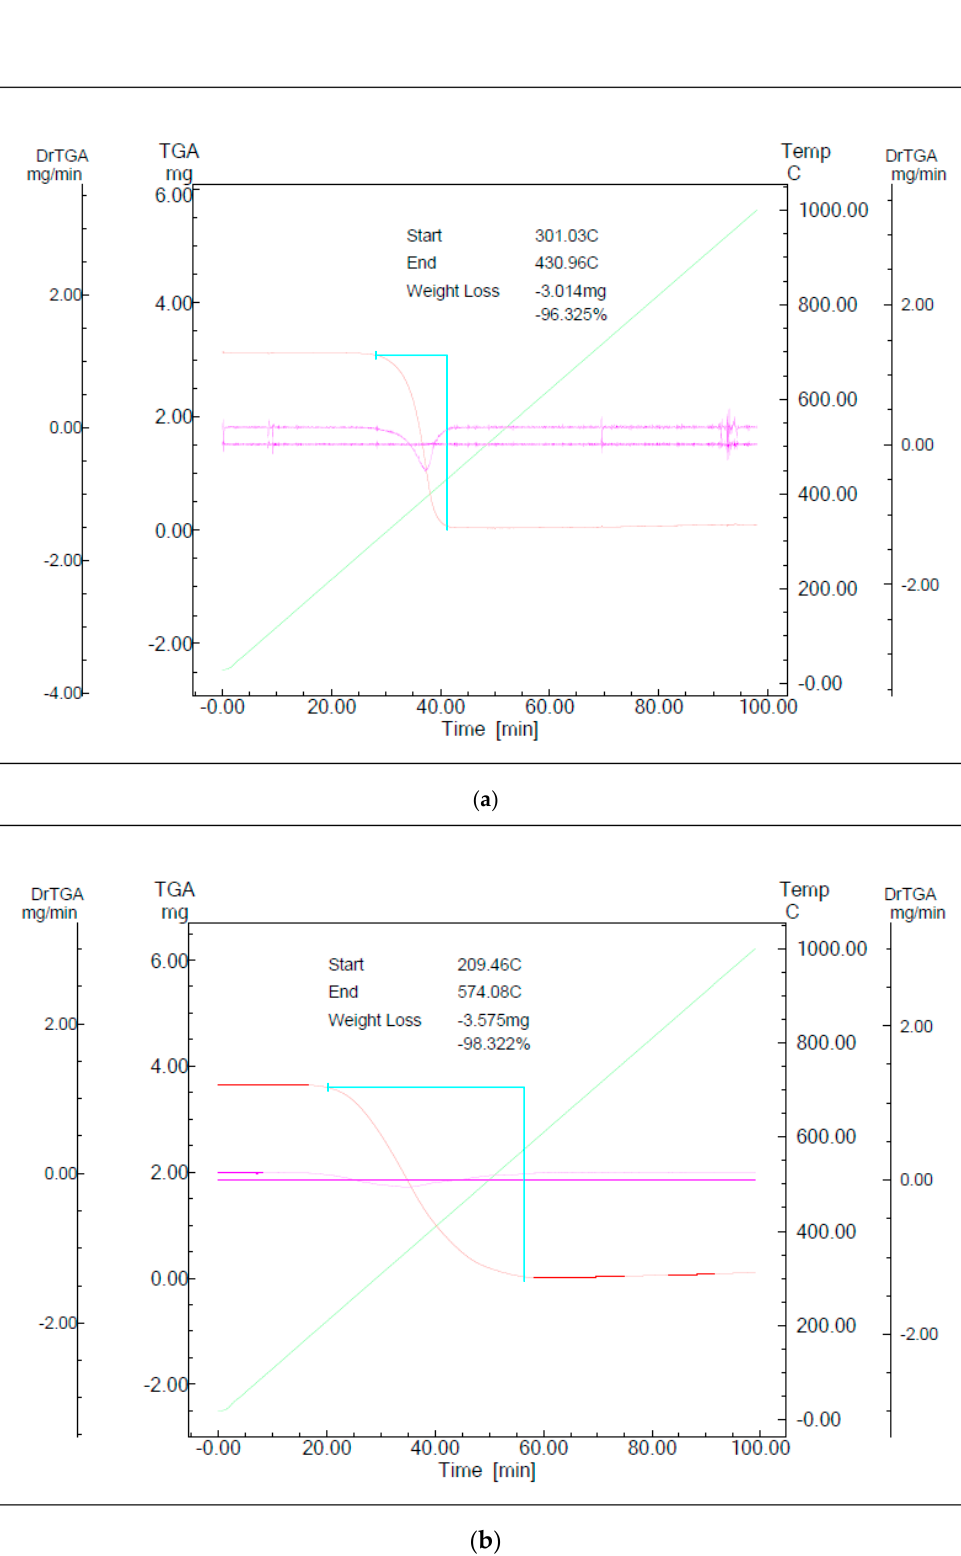
Figure A12. TGA Sample AA-50T-50M ( a ) Nitrogen atmosphere ( b ) air